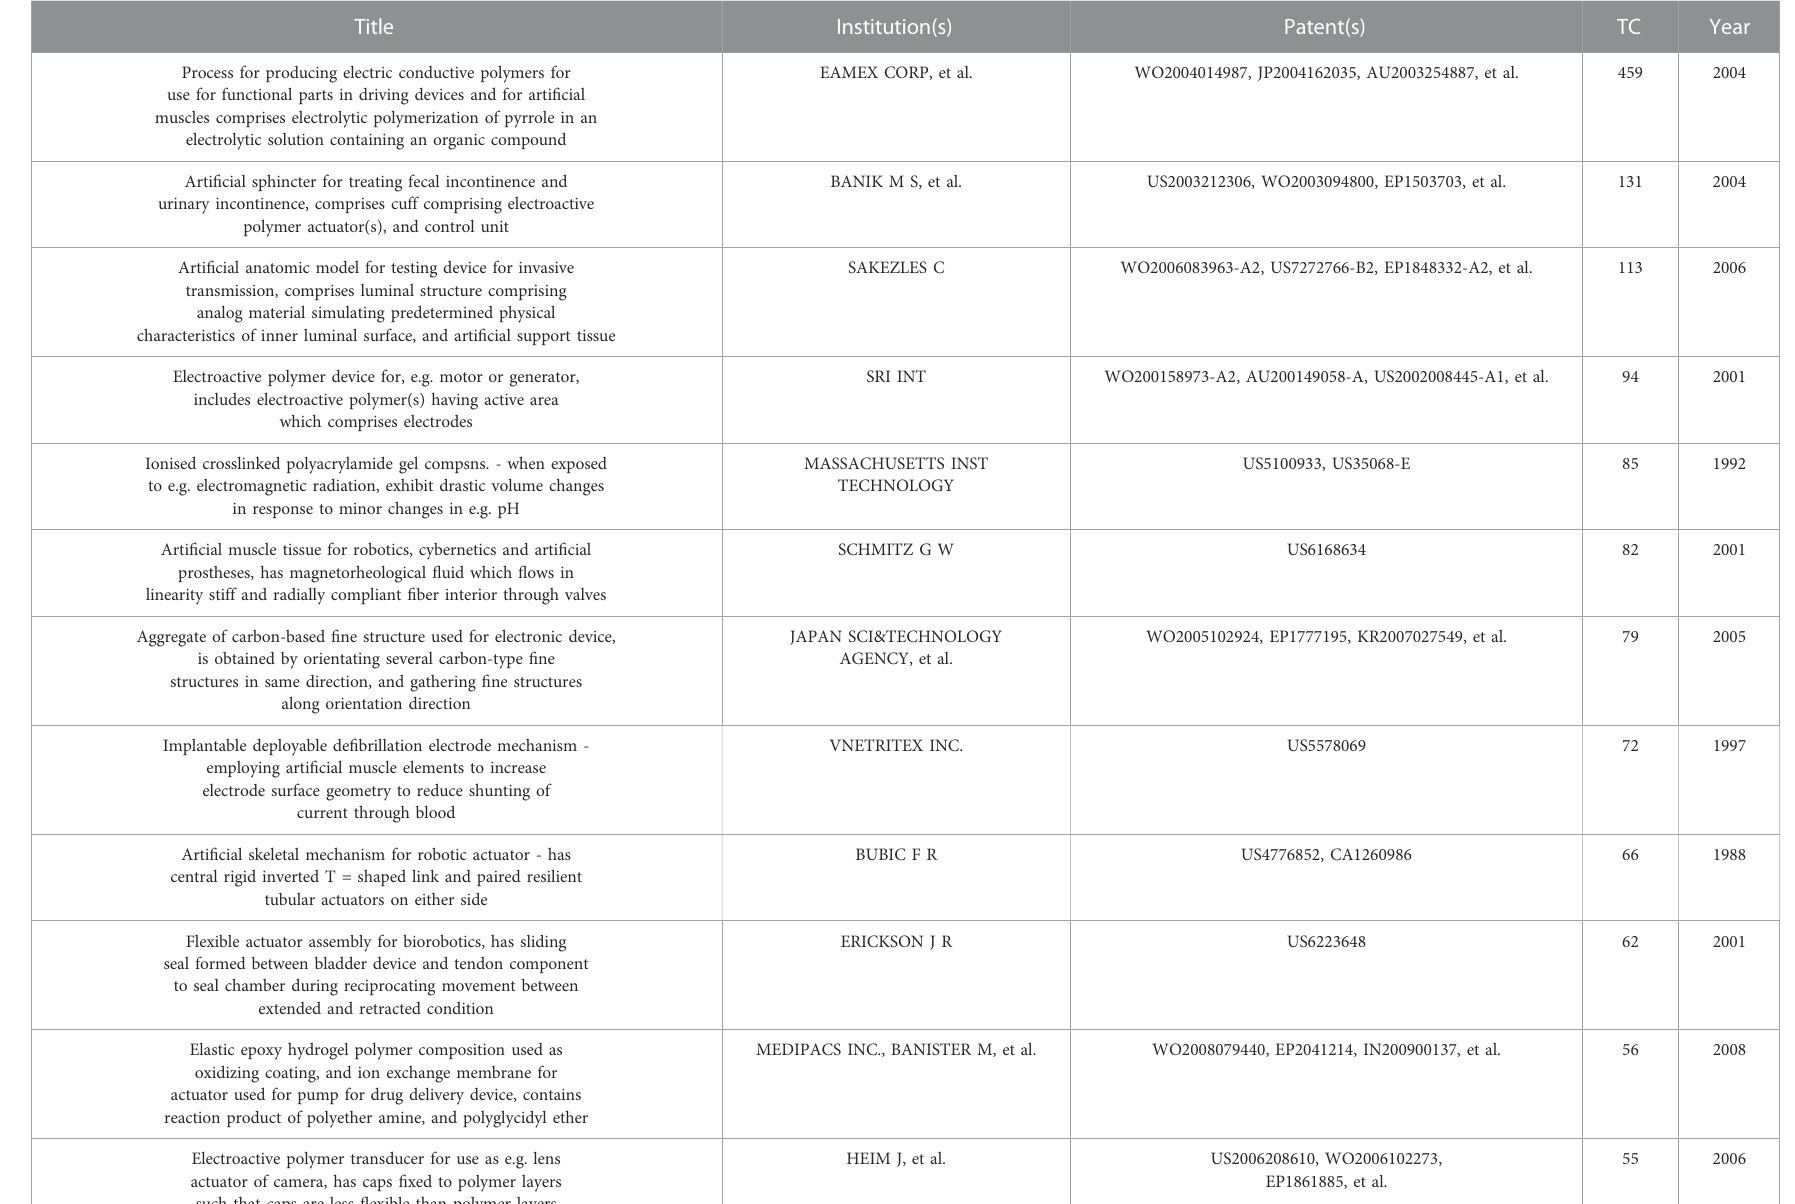
Institution(s) Patent(s) TC Year EAMEX CORP, et